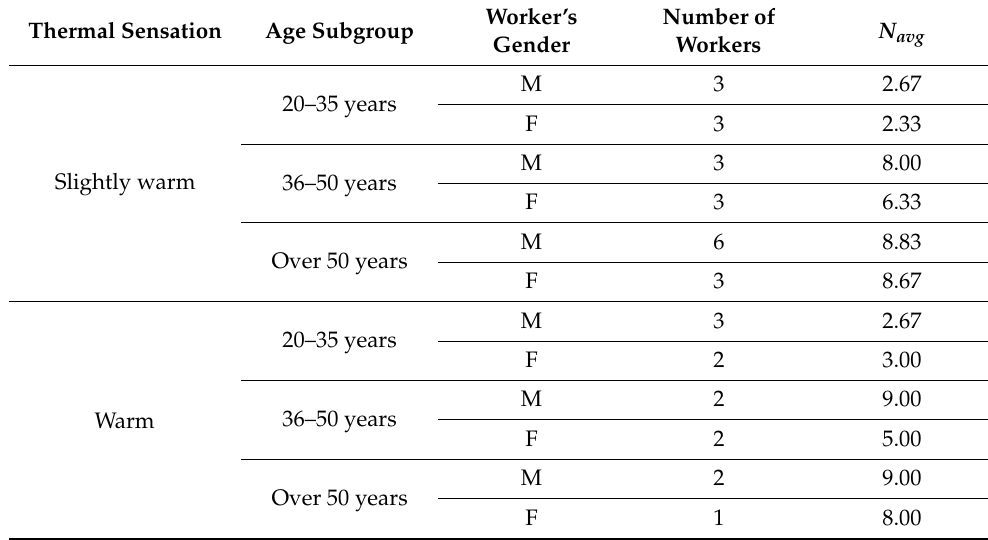
Table 5. Analysis of the workers’ responses to the questionnaire. Thermal